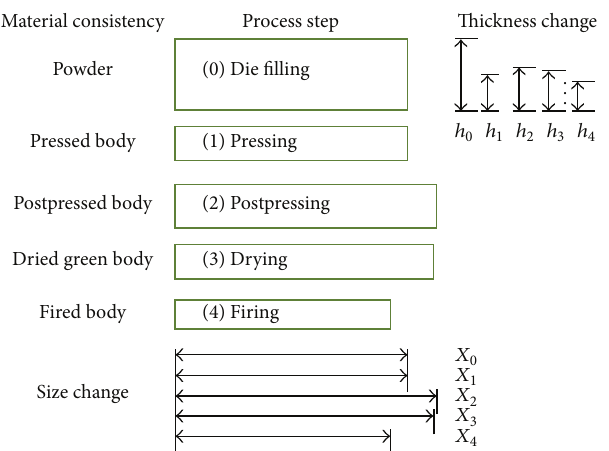
Figure 1: Dimensional changes through the process of porcelain